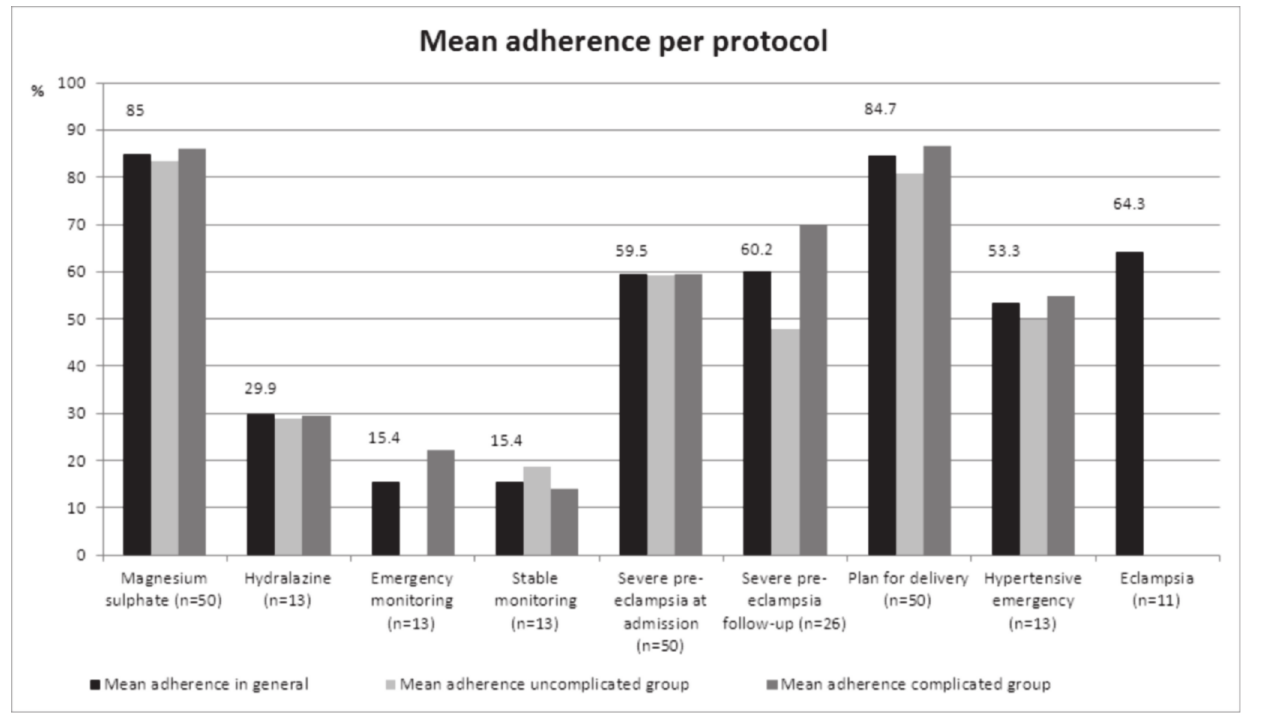
Fig 3. Mean adherence per protocol for total study sample and stratified by uncomplicated and complicated severe pre-eclampsia (n = 50), Ridge Regional Hospital, Accra, Ghana,